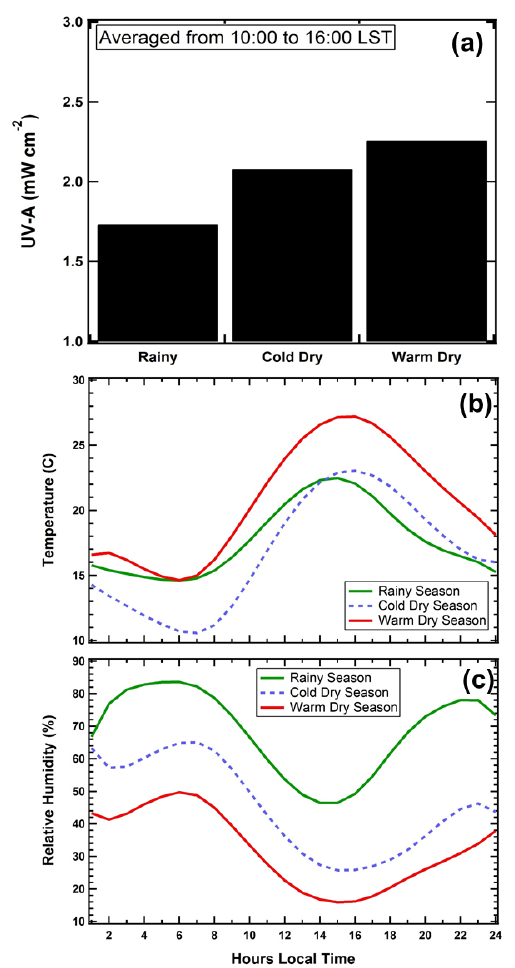
Figure 7. (a) The average daily accumulated UV-A is shown in the bar chart, illustrating the impact of clouds during the rainy season when the sun reaches its maximum elevation angle at the Mexico City latitude. The (b) average hourly and seasonal temperature and (c) relative humidity are separated by season: warm-dry (red), rainy (green) and cold-dry (blue).